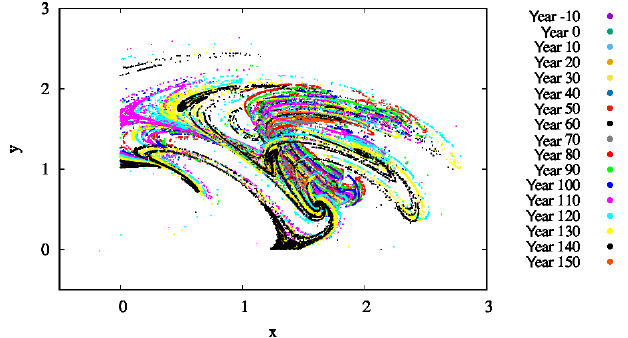
Figure 9. The projection of the z = 0 and ˙ z > 0 section of the snap- shot attractors on the x – y plane for β = 0 . 1, α = 0 . 05, and γ = 0 . 1. The snapshot attractors at intervals of 10 years are shown with purple ( t = − 10 years), green ( t = 0 years), cyan ( t = 10 years), light orange ( t = 20 years), yellow ( t = 30 years), dark cyan ( t = 40 years), dark red ( t = 50 years), dark grey ( t = 60 years), grey ( t = 70 years), red ( t = 80 years), light green ( t = 90 years), blue ( t = 100 years), pink ( t = 110 years), light blue ( t = 120 years), bright yellow ( t = 130 years), black ( t = 140 years), and dark or- ange ( t = 150 years). They are generated by initiating 7 × 10 7 ran- dom initial conditions at year −